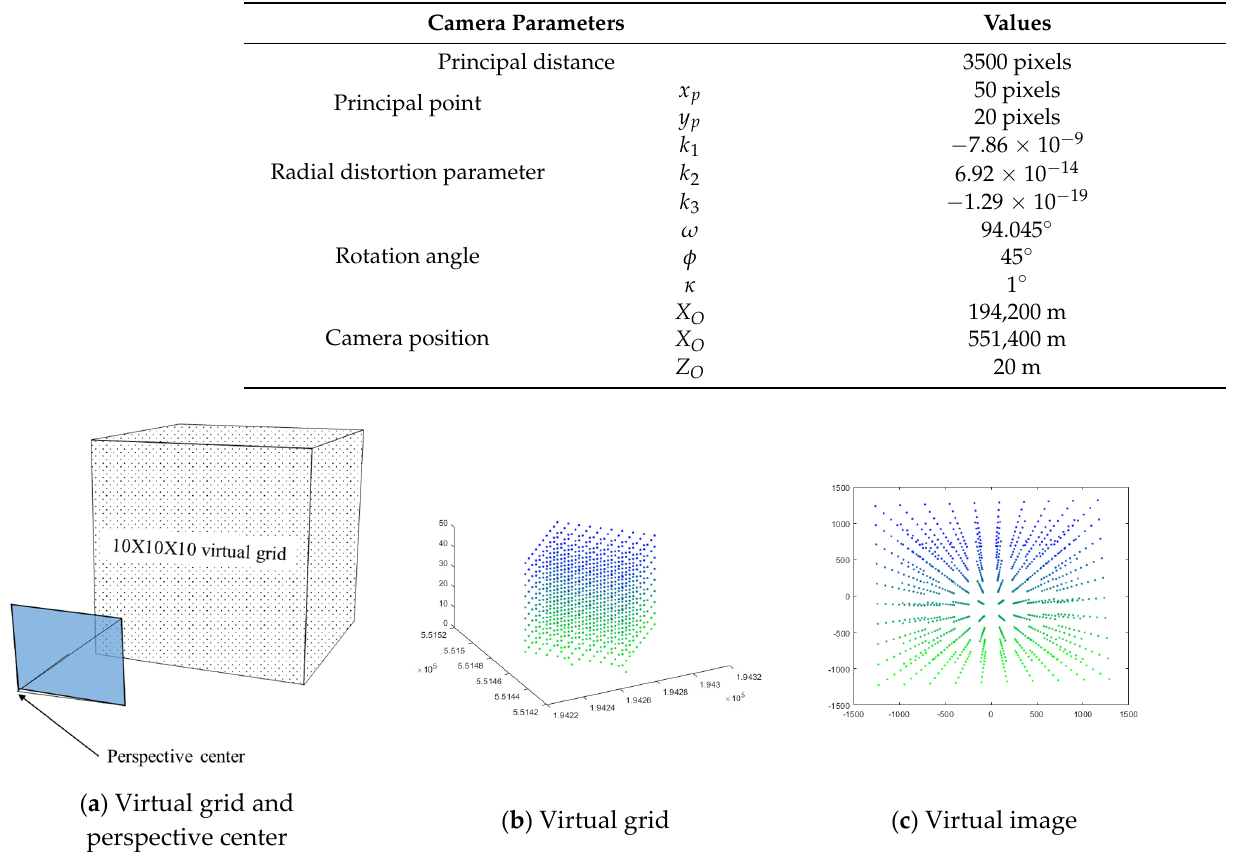
Table 2. Camera parameters, IOPs, and EOPs.